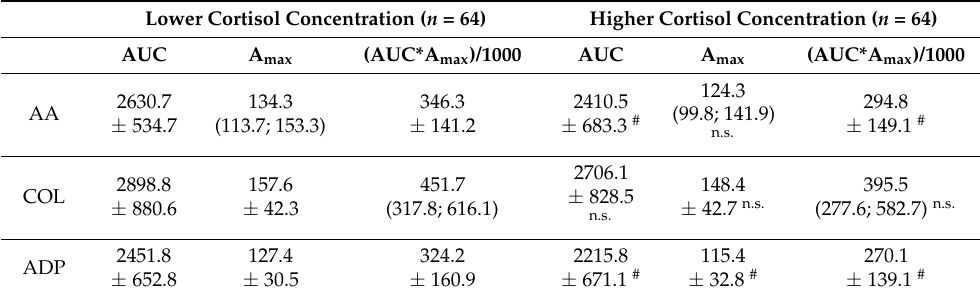
Table 2. Reactivity of blood platelets in dependence on plasma concentration of cortisol. Lower Cortisol Concentration ( n =